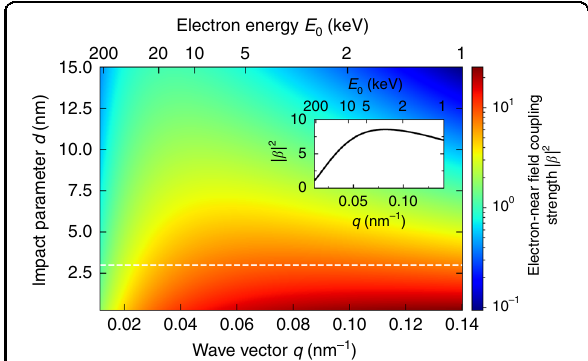
Fig. 6 Electron energy dependence of the electron-near- fi eld coupling strength. BEM calculation of the laser-induced electron- near- fi eld coupling strength β j j 2 as a function of the along-the-beam wave vector q ¼ ω = v and impact parameter d relative to the tip apex. Data are obtained for a fi xed photon energy of (cid:1) h ω = 1.73 eV matching the tip resonance energy and for varying electron energies E 0 (see top axis). Other excitation parameters are identical to those in Figs. 4c and 5d. The inset shows a pro fi le along the white dashed line for d = 3 nm, representing the local spatial Fourier composition of the optical fi eld along the electron trajectory. For a given E 0 , the electron can only couple to the Fourier fi eld component with a spatial phase advance q , affecting both the amplitude and the spatial distribution of β j j